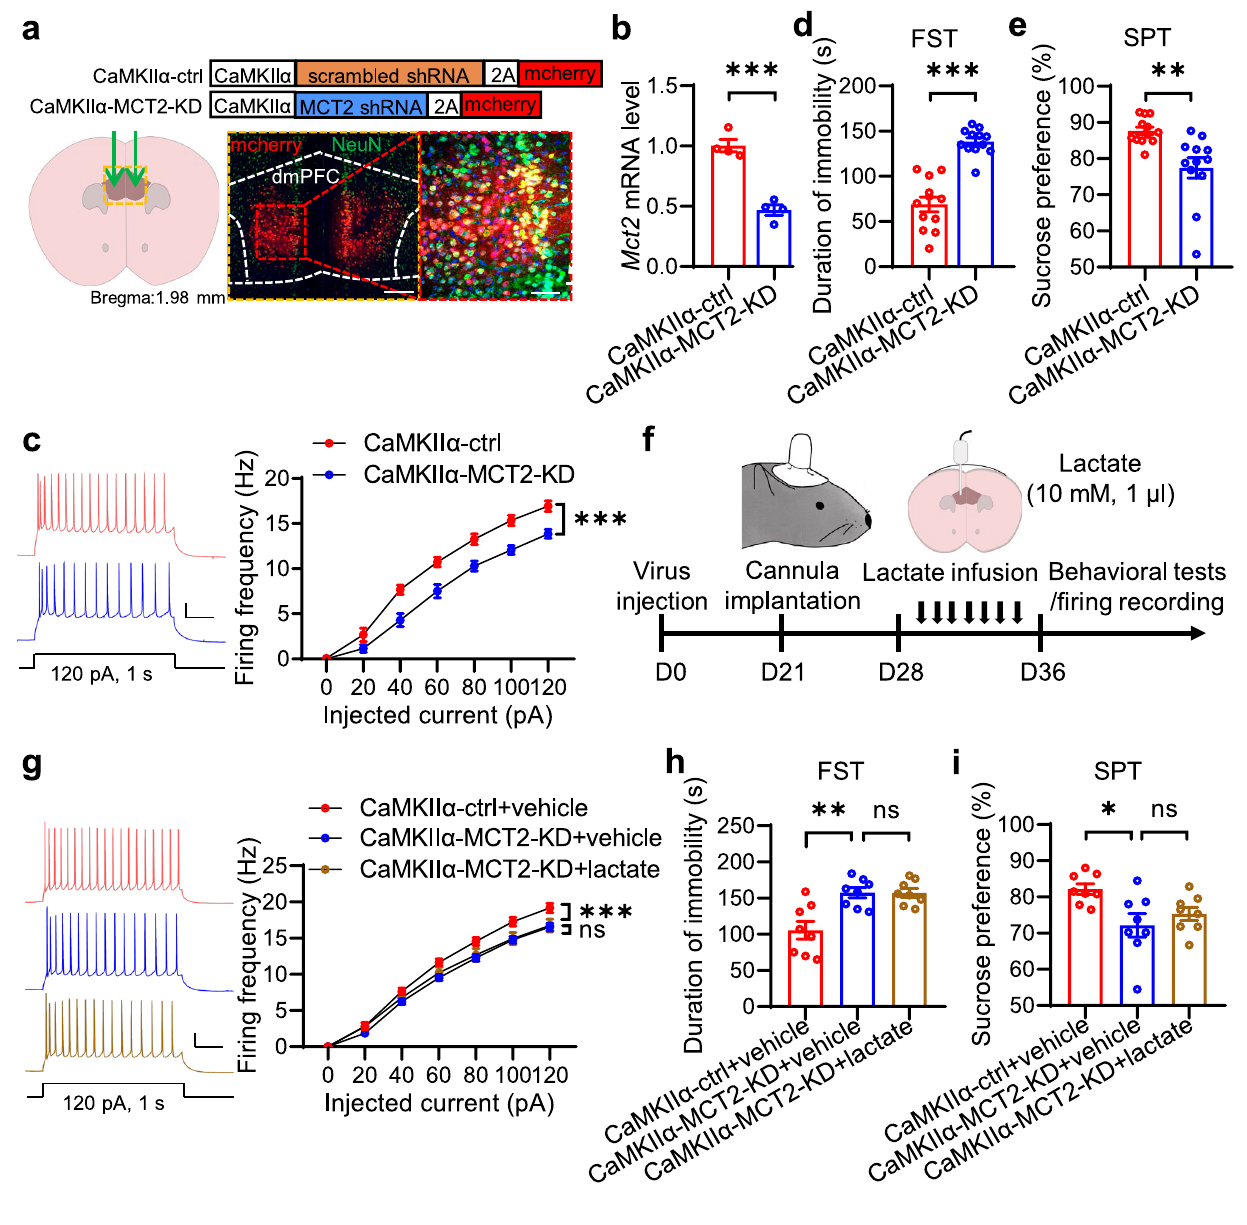
Fig. 6 | Neuronal MCT2 in the dmPFC mediates the anti-depressive effects of KD+vehicle mice and 4 CaMKII α -MCT2-KD+L-lactate mice. Two-way ANOVA, for L-lactate. a Illustration of viral injections. Scale bars: left, 150 µ m; right, 50 µ m. CaMKII α -MCT2-KD+vehicle vs CaMKII α -ctrl+vehicle, gene effect, F (1,266) =53.06, p =0.0000;forCaMKII α -MCT2-KD+L-lactatevsCaMKII α -ctrl+vehicle,geneeffect, b Reduced Mct2 mRNAlevelbyshRNAagainstMct2. n =4micepergroup.Student ’ s p =0.0002. c Compromised neuronal excitability of neurons in t -test, t F (1,273) =1.974, p =0.1611. h , i Diminished effect of L-lactate on the immobility (6) =7.928, dmPFC of CaMKII α -MCT2-KD mice. Left, representative fi ring traces. Scale bars: duration( h )andsucrosepreference( i )byMCT2knockdown. n =8micepergroup. 0.2s,20mV.Right,quantitativedata. n =15and14neuronsfrom4CaMKII α -ctrland One-way ANOVA followed by Tukey ’ s post hoc test. For FST, F (2,21) =8.067, p =0.0025. CaMKII α -MCT2-KD+vehicle vs CaMKII α -ctrl+vehicle, p =0.0051; 4 CaMKII α -MCT2-KD mice. Two-way ANOVA, gene effect, F (1,189) =75.12, p =0.0000. d , e Increased immobility duration ( d ) and decreased sucrose pre- CaMKII α -MCT2-KD+L-lactate vs CaMKII α -ctrl+vehicle, p =0.9853. For SPT, ference ( e ) of CaMKII α -MCT2-KD mice. n =12 mice per group. Student ’ s t -test, for F (2,21) =5.041, p =0.0163. CaMKII α -MCT2-KD+vehicle vs CaMKII α -ctrl+vehicle, p =0.0142; CaMKII α -MCT2-KD+L-lactate vs CaMKII α -ctrl+vehicle, p =0.5953. Data FST, t (22) =7.514, p =0.0000; for SPT, t (22) =3.417, p =0.0025. f Experimental time scheme. g Diminished effect of L-lactate on neuronal excitability by MCT2 knock- were shown as mean±SEM. * p <0.05, ** p <0.01, *** p <0.001; ns, no signi fi cant down.Left,representative fi ring traces.Scale bars:0.2s,20mV.Right,quantitative difference. Source data are provided as a Source Data fi data. n =18, 22 and 19 neurons from 4 CaMKII α -ctrl+vehicle, 4 CaMKII α -MCT2-